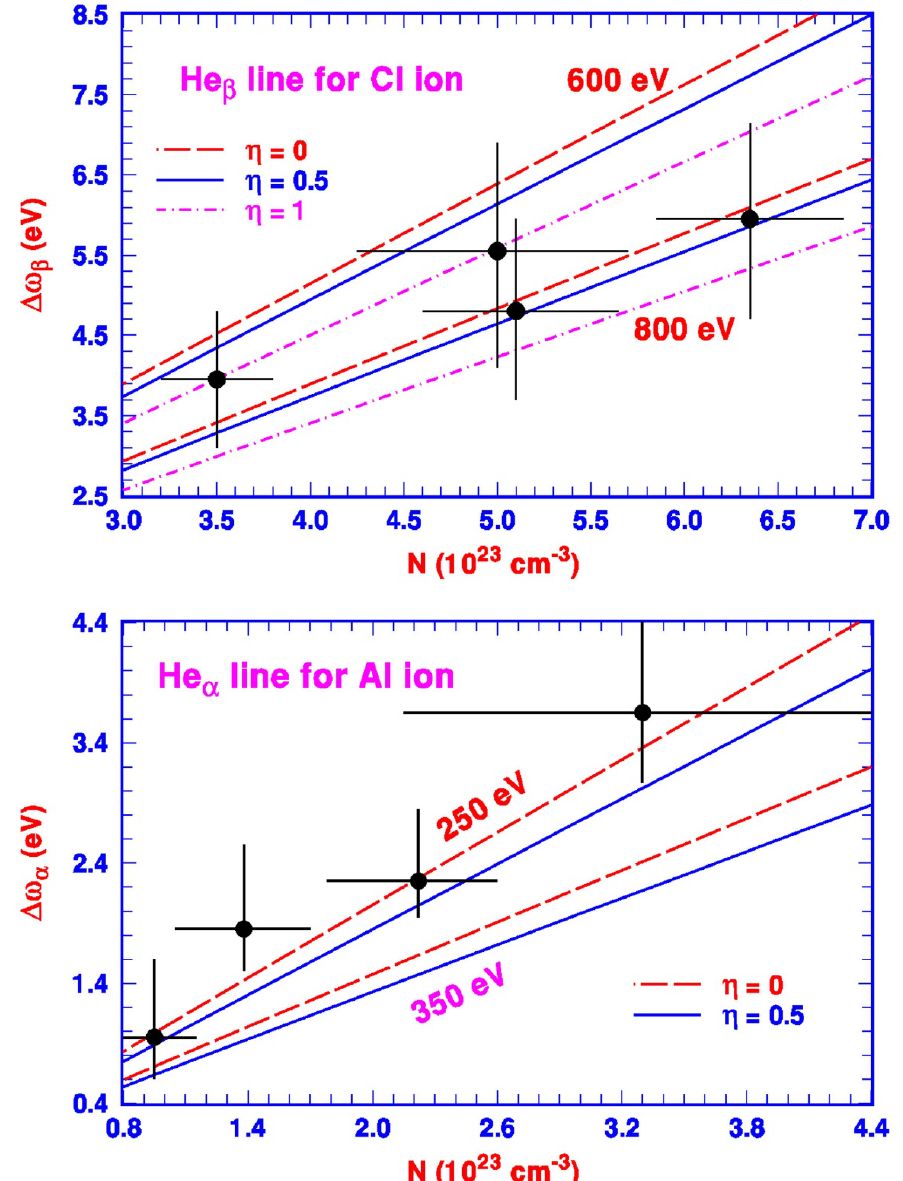
Figure 3. The comparison between the redshifts ∆ ω for the β and α emissions of the He-like ions estimated based on the DH approximation with the recent dense plasma experiments for the He-like Cl ion between 600 eV and 650 eV [15] and the Al ion between 250 eV and 375 eV [14],